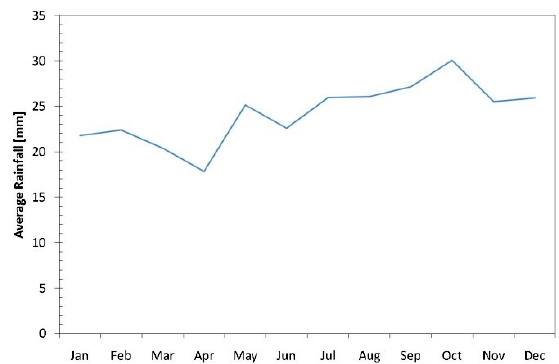
Fig. 6. Annual rainfall from 1947 until 2013 for Mildura Airport (source : Bureau of Meteorology 2014)